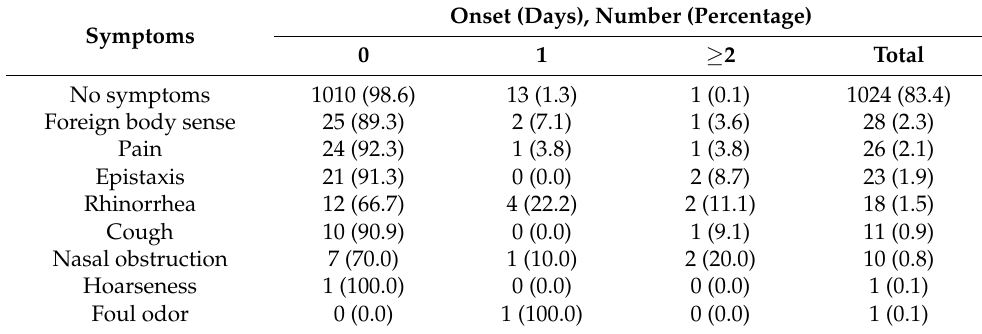
Table 4. Symptoms according to the onset of foreign body